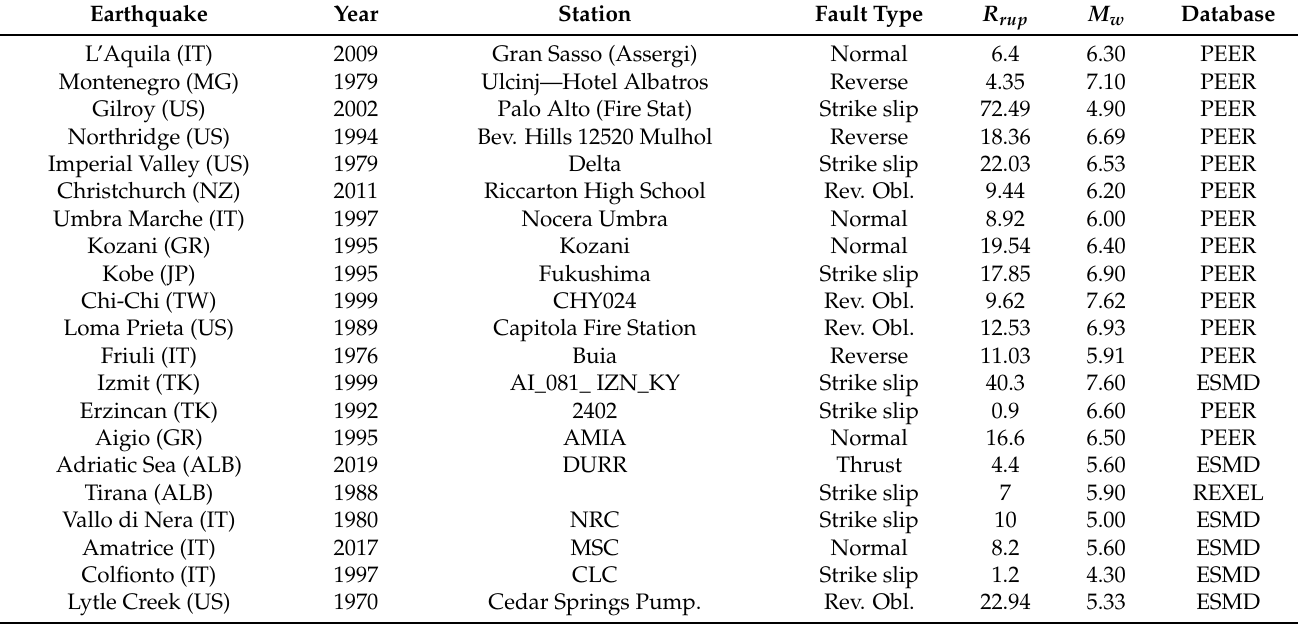
Table A1. Earthquakes used in the simulated